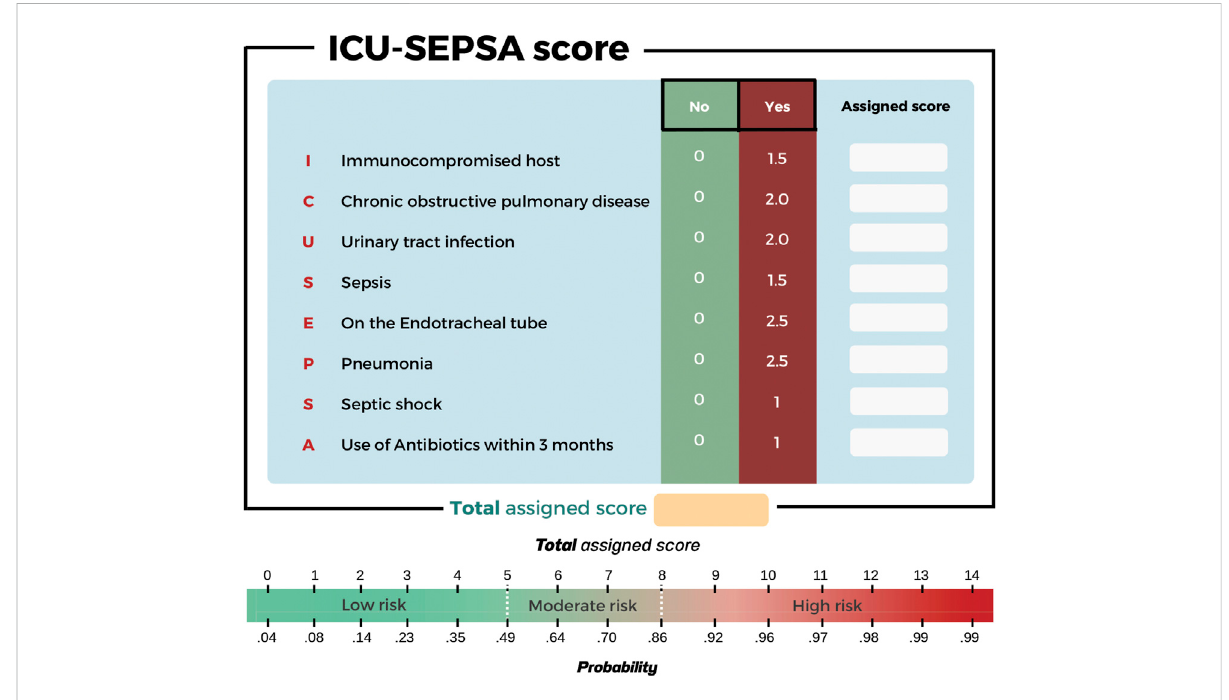
FIGURE 2 Visualize used for predicting mortality in patients with MDR infection.